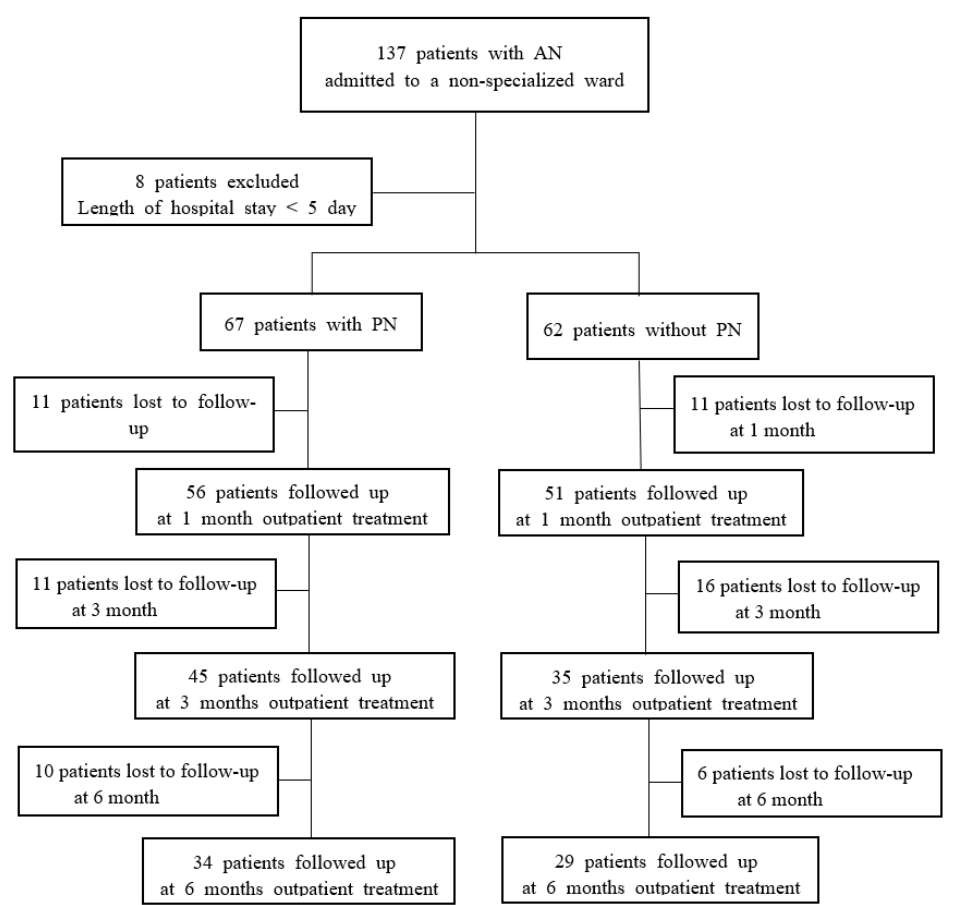
Figure 1. Flow-diagram of the study participants. Abbreviations: AN, anorexia nervosa; PN, parenteral nutrition. Table 1. Clinical characteristics of AN patients with anorexia nervosa at admission. Patients with PN Patients without PN